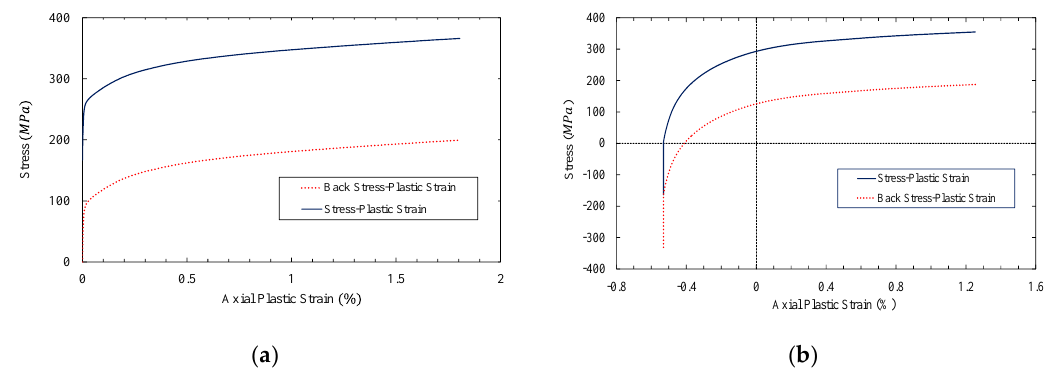
Figure 12. Stress-plastic strain and Backstress for elastic limit = 167.2 MPa obtained from ( a ) post-stabilized monotonic curve, ( b ) hysteresis curve.